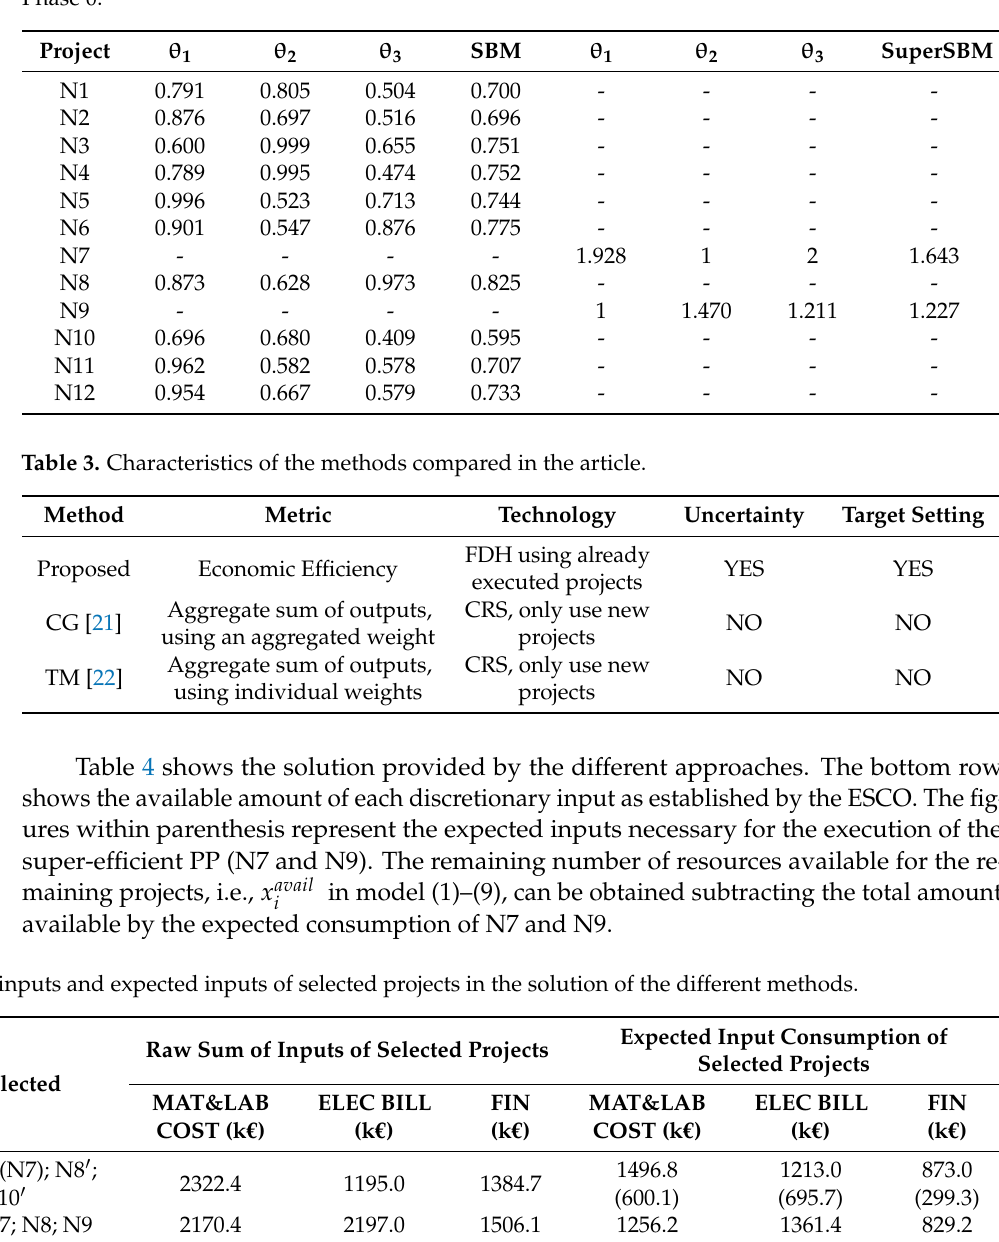
Table 2. Slacks-based measure (SBM) and super-SBM efficiency scores of new projects provided by Phase 0.